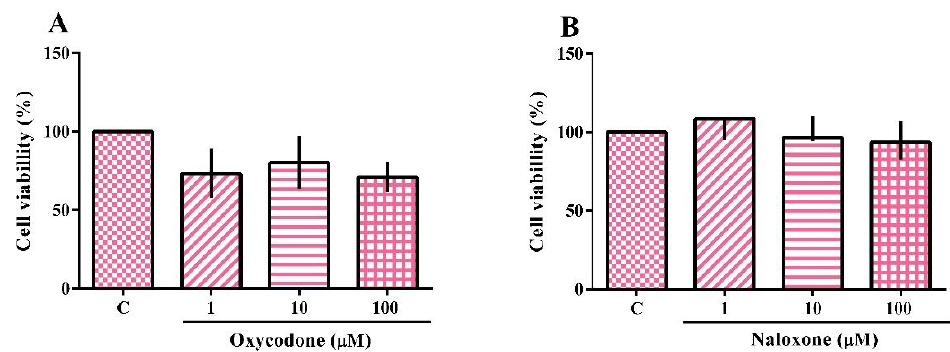
Figure 1. Cytotoxicity analysis of a neuroblastoma cell line (SH-SY5Y) exposed for 24 h to oxycodone ( A ) and naloxone ( B ). The results were analyzed by the Kruskal–Wallis test followed by Dunn’s ( A ) and naloxone ( B ). The results were analyzed by the Kruskal – Wallis test followed by Dunn ’ s post-test and presented as the median ± interquartile interval ( n = 3–4). C: control, nonexposed post-test and presented as the median ± interquartile interval ( n = 3 – 4). C: control, nonexposed cells.